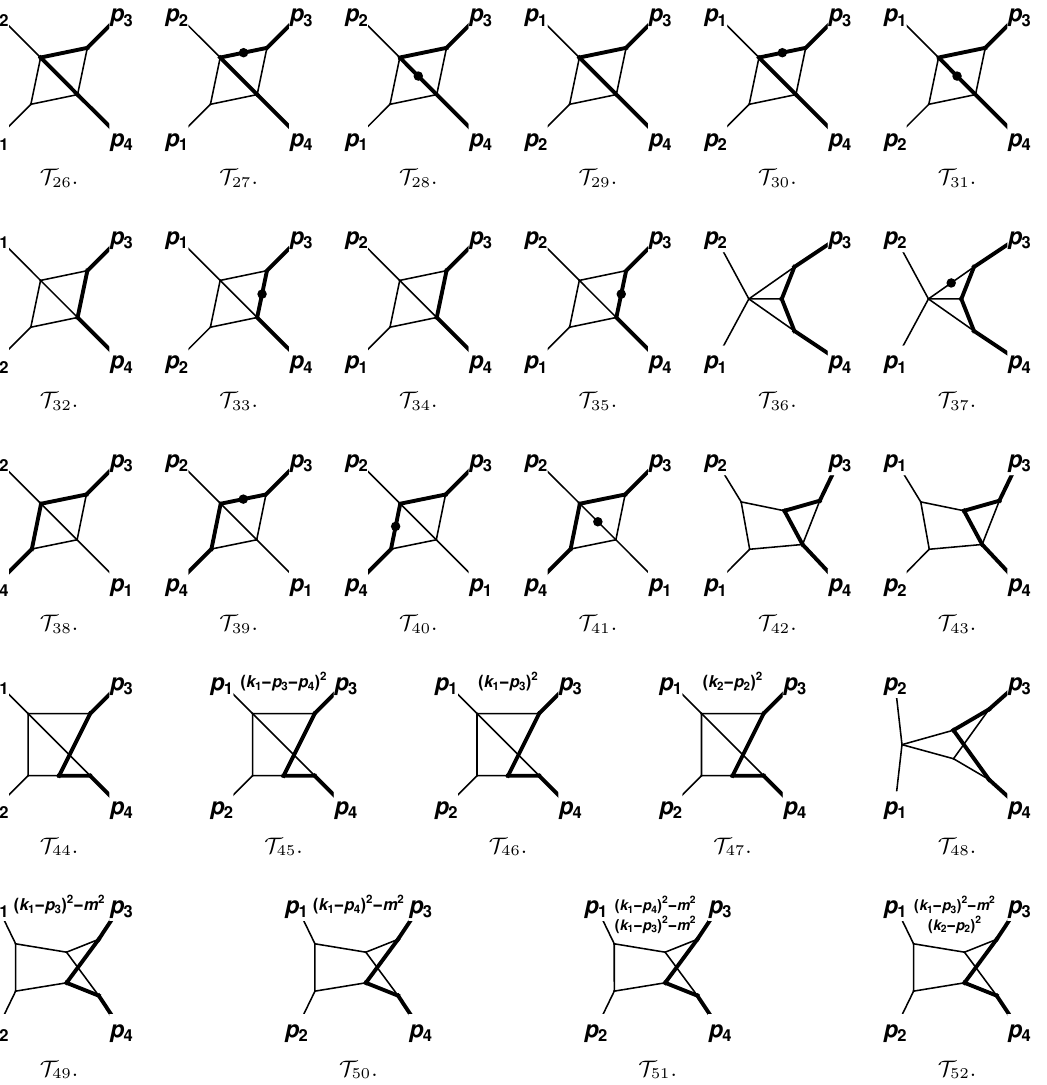
Figure 3. The remaining 27 MIs T 26 ;:::; 52 for the two-loop non-planar topology N 2 of (cid:12)gure 1. The conventions are the same as in (cid:12)gure